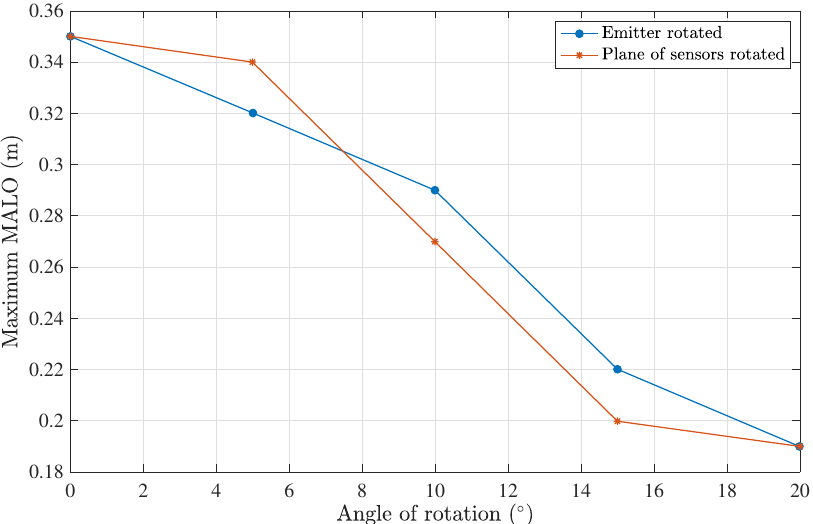
Figure 14. The maximum MALO as a function of the rotation angle, considering a harbor II water type, a Tx–Rx distance of 0.5m and a 7-lens scheme.